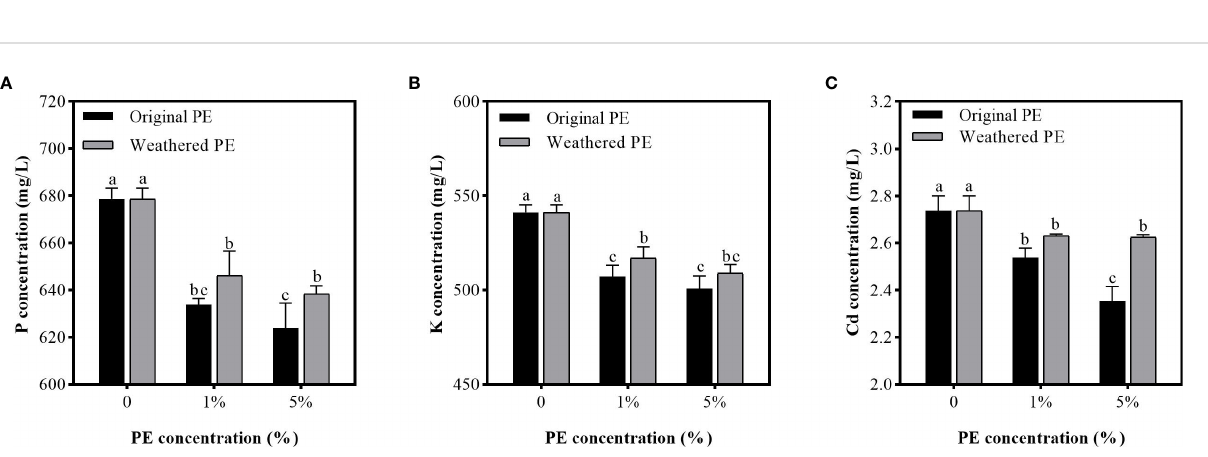
FIGURE 3 P (A) , K (B) and Cd (C) concentrations in PE MPs treated solutions. Solution samples are collected after been treated by original or weathered PE MPs (0, 1% and 5%) for 7 days. Different letters in each fi gure indicate signi fi cant (p < 0.05) differences according to Tukey ’ s test.